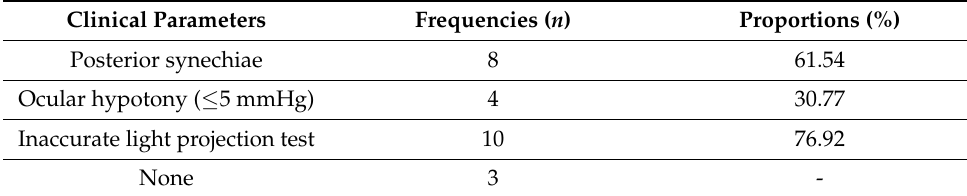
Table 3. Clinical risk factors for retinal detachment ( n =